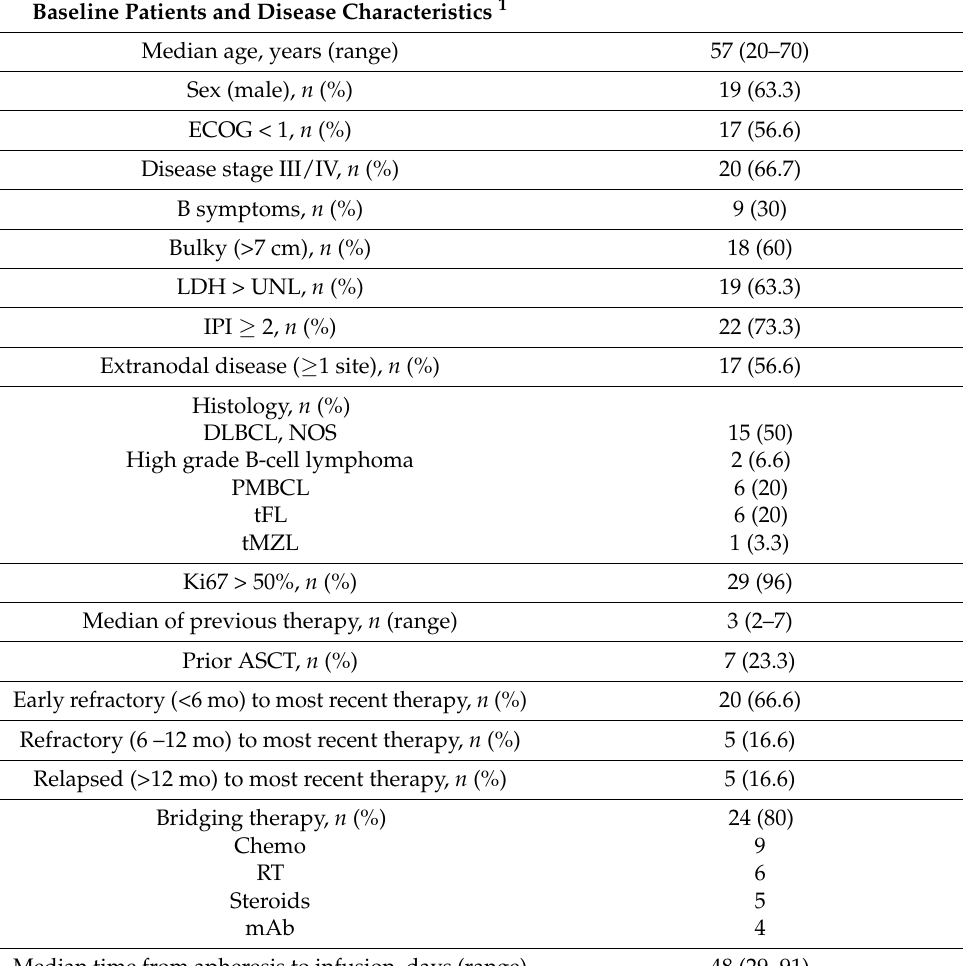
Table 1. Baseline characteristics of enrolled